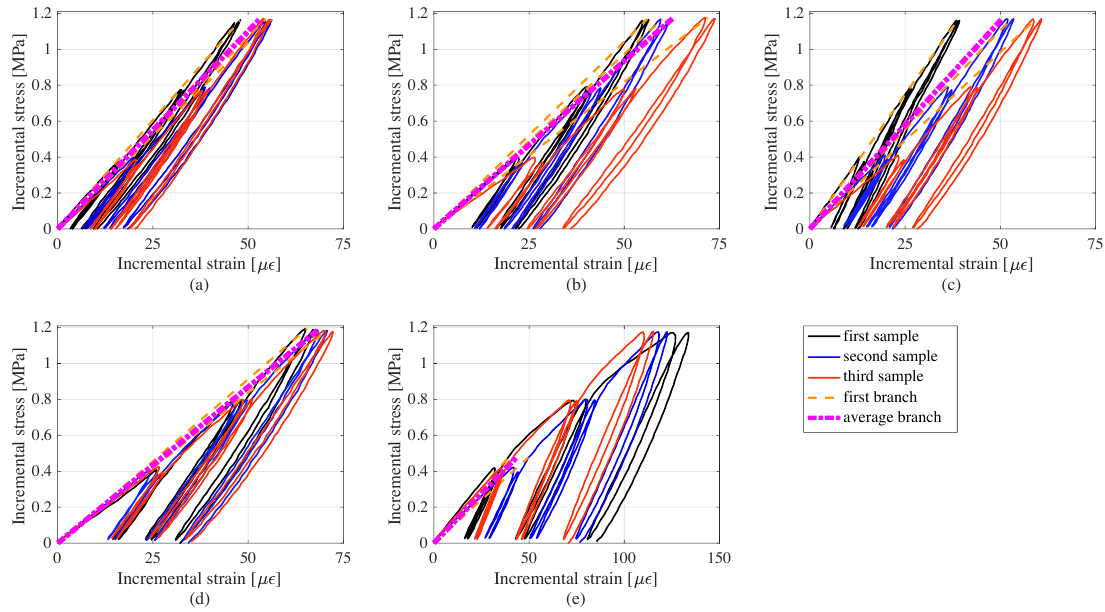
Figure 9. Stress versus strain curves for all samples: ( a ) 0%; ( b ) 10%; ( c ) 20%; ( d ) 30%; and ( e ) 40% graphite-to-cement ratios.